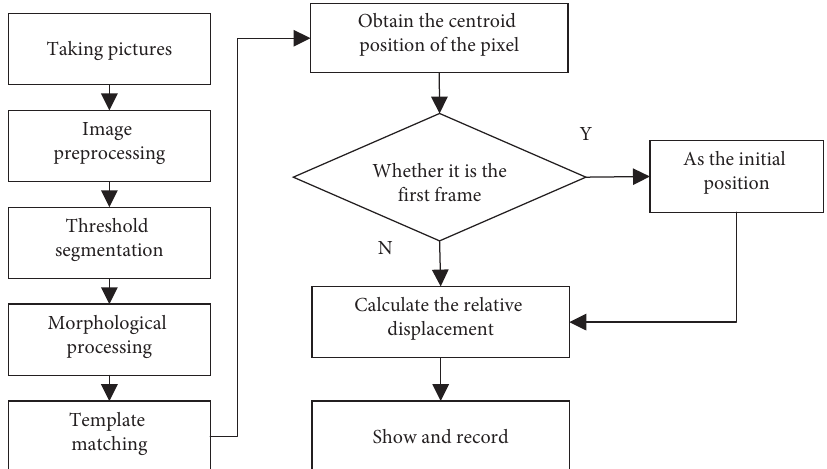
Figure 5: Flow chart of image processing and laser spot centroid